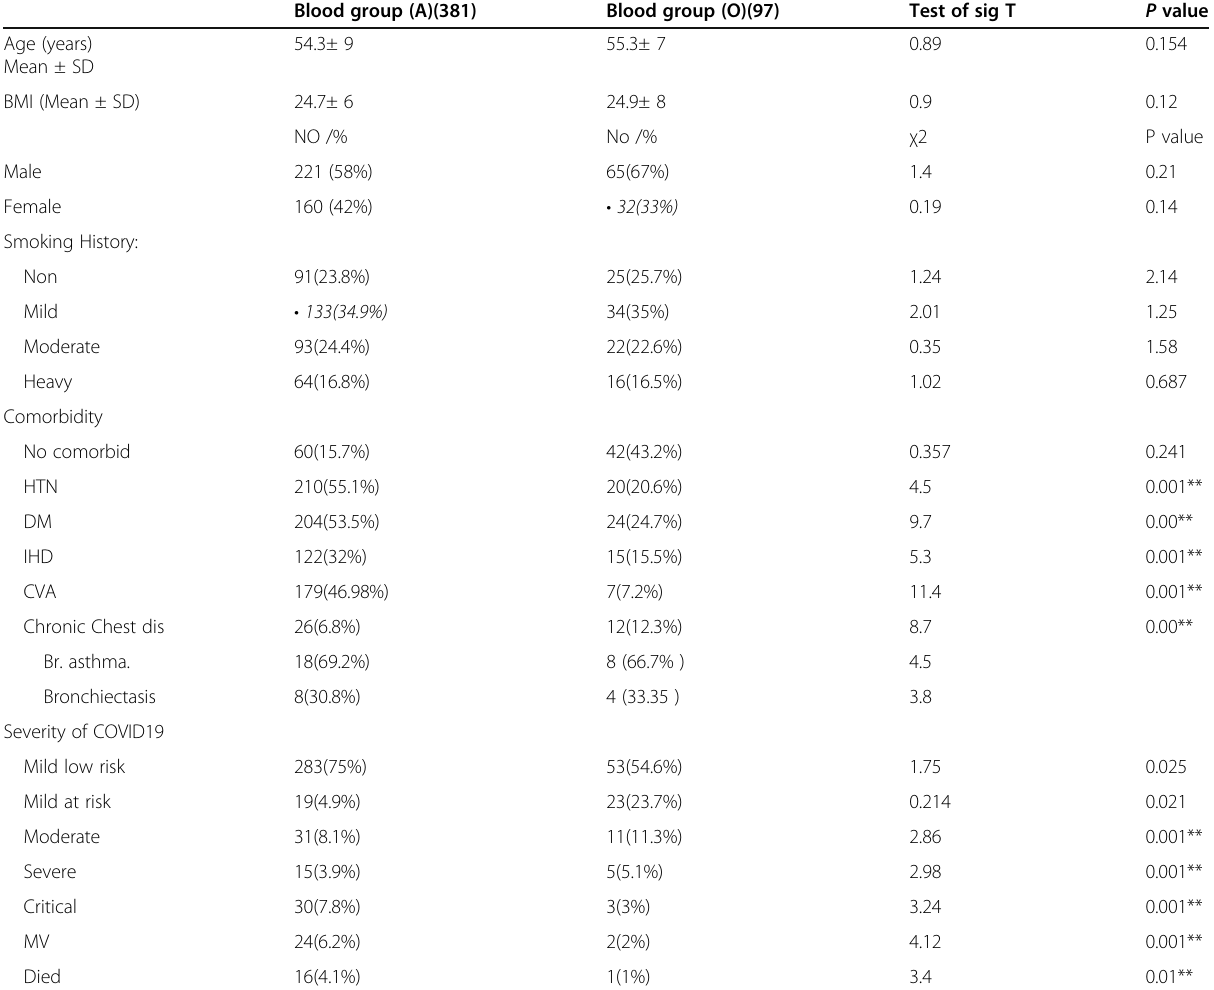
Table 2 Comparison between blood group A and blood group O regarding epidemiological characters of COVId19 patients Blood group